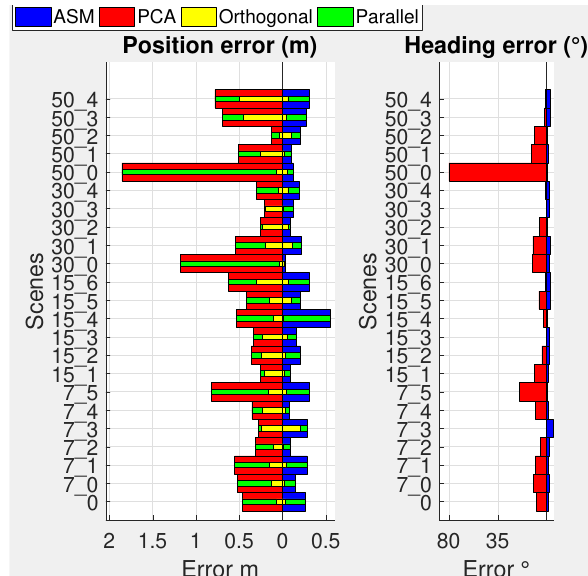
axis. The BC-PCA orthogonal error for the van is higher Figure 7. The absolute errors of the detections of the sedan type car in the HDL-64 scans. The position error (left) includes the error ratio orthogonal (yellow) and parallel (green) to the car axis error diagram (Figure 7) in scene 7 5 , 30 0 and 50 0 identify